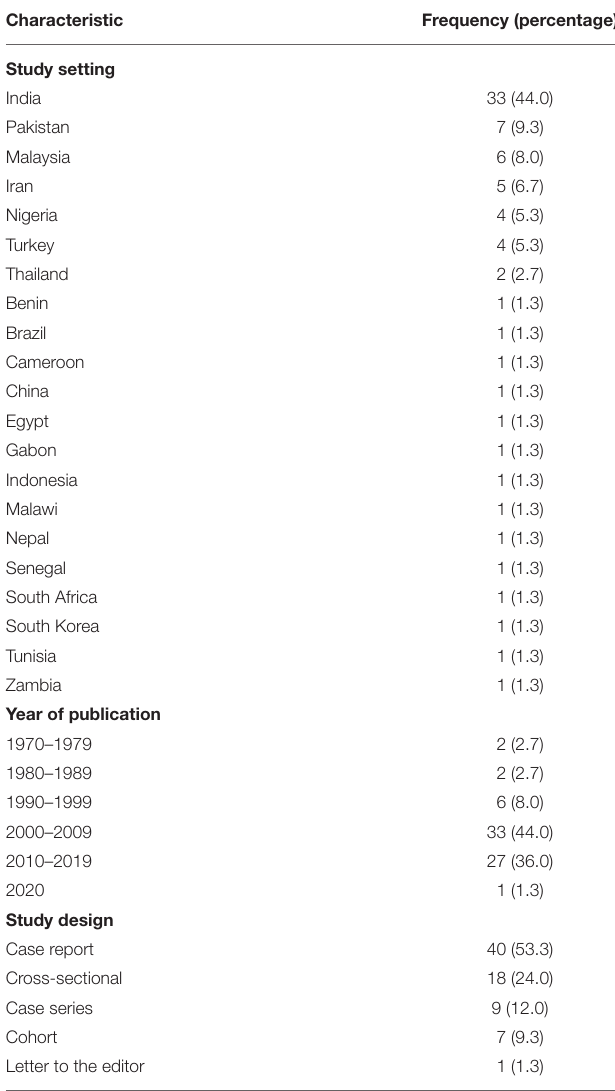
TABLE 1 | Characteristics of the 75 studies included in the